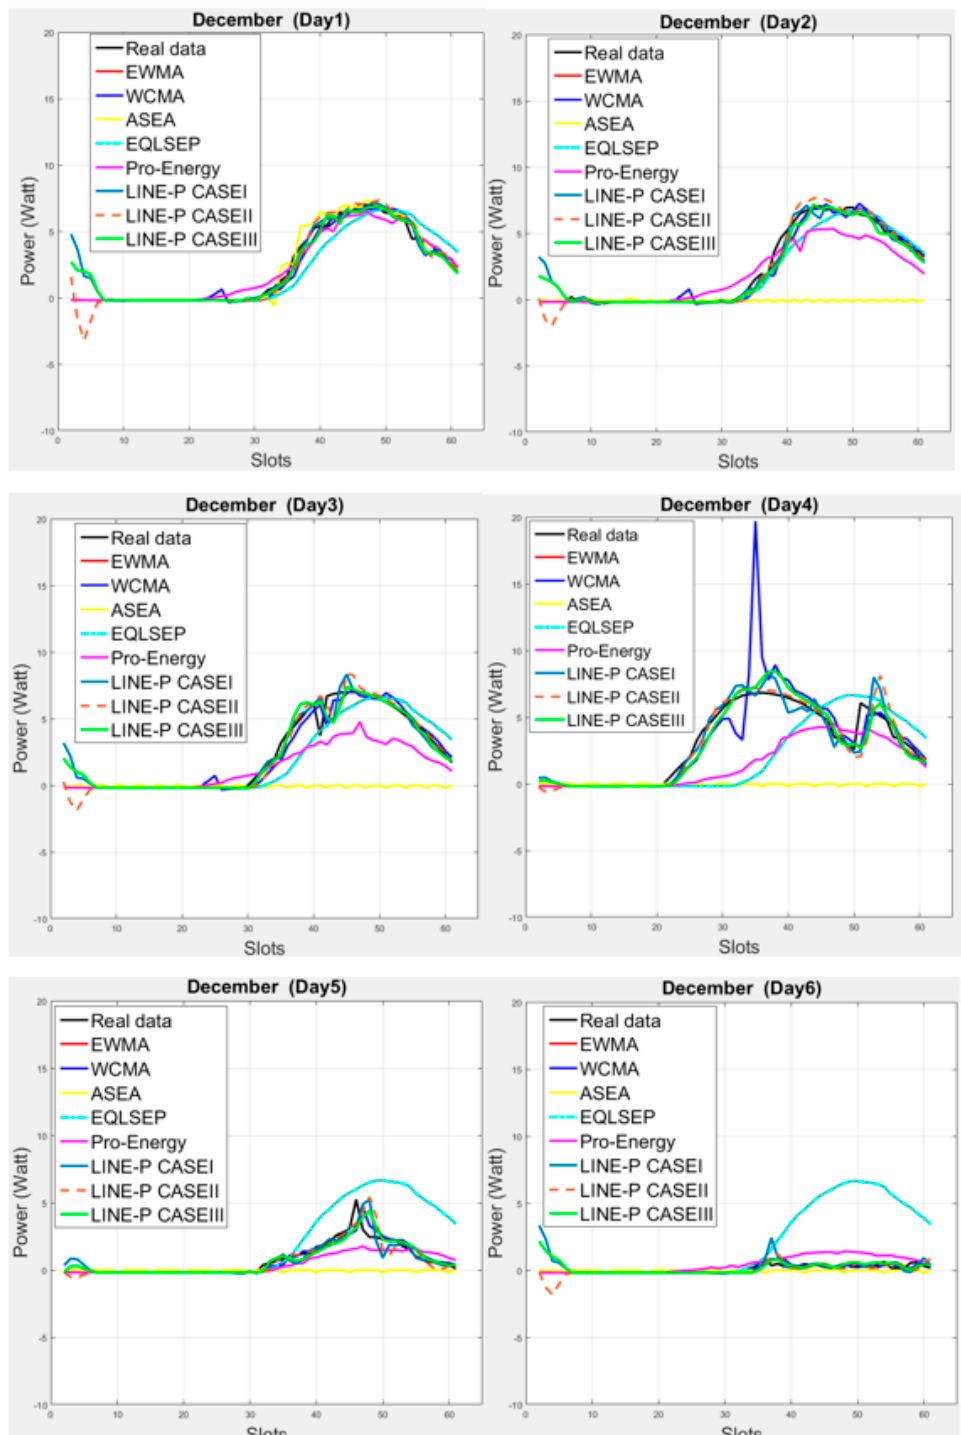
Figure 2. Graphical comparison of the obtained predictions for all energy prediction models (including the proposed LINE-P cases) for medium interval-based (61 slots) solar energy in December. Solar energy variations are troublesome for some of the models (e.g., EWMA and QL-SEP models on the 5th and 6th days, and ASEA on the 2nd day). On the other hand, ASEA is able to yield suitable predictions for longer intervals. In any weather situation, all three cases of LINE-P provide predictions very close to the real dataset.